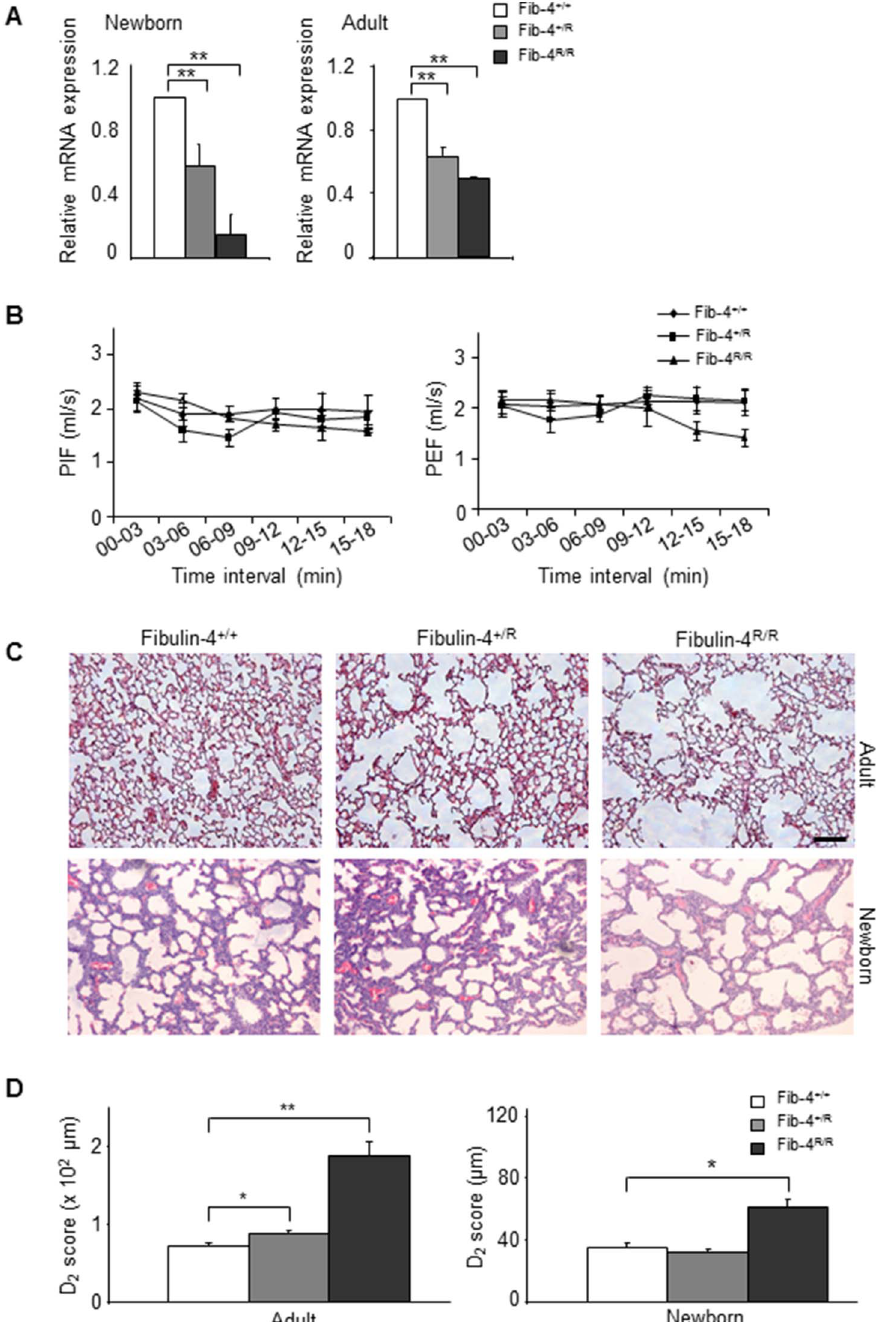
Figure 3. Enlarged alveolar airspaces in lungs of Fibulin-4 knockdown mice. (A) Expression levels of Fibulin-4 in lungs isolated from newborn (n=4, n=4, n=3) and adult (n=4, n=4, n=4) Fibulin-4 + / + , Fibulin-4 + /R and Fibulin-4 R/R mice relative to Fibulin-4 + / + lungs (**p , 0.01). (B) Mean peak inspiratory flow (PIF) and peak expiratory flow (PEF) values for Fibulin-4 + / + (n=4), Fibulin-4 + /R (n=4) and Fibulin-4 R/R mice (observed for n=4, but two animals died during the procedure) at 3-minute intervals. After a 9 minute adaptation period (the first three time intervals), PIF follows similar trends in Fibulin-4 + / + , Fibulin-4 + /R and Fibulin-4 R/R mice, while Fibulin-4 R/R mice show a decrease in PEF. (C) HE stained sections of formalin fixed lungs of male mice. Enlarged alveolar airspaces are observed in Fibulin-4 + /R (middle, n=3) and Fibulin-4 R/R lungs (right, n=3), with the latter being more pronounced, compared to Fibulin-4 + / + (n=3). Enlarged alveolar airspaces are already present in Fibulin-4 R/R newborn lungs (n=3), while lungs of Fibulin-4 + /R littermates (n=5) show no difference compared to Fibulin-4 + / + lungs (n=4). Scale bar 100 m m. Magnification 10x. (D) D 2 quantification (see methods and Figure S1 for further explanation) of the alveolar airspaces revealed a significant difference between adult Fibulin-4 + / + and Fibulin-4 + /R (*p , 0.05) and between adult Fibulin-4 + / + and Fibulin-4 R/R lungs (**p , 0.01) as well as between newborn Fibulin-4 + / + and Fibulin-4 R/ R lungs (*p , 0.05).